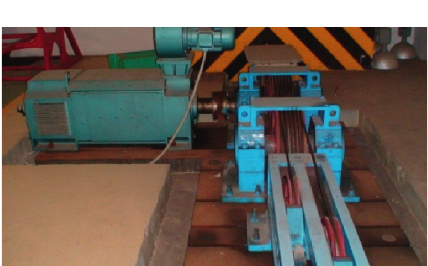
Figure 2: Sled track.